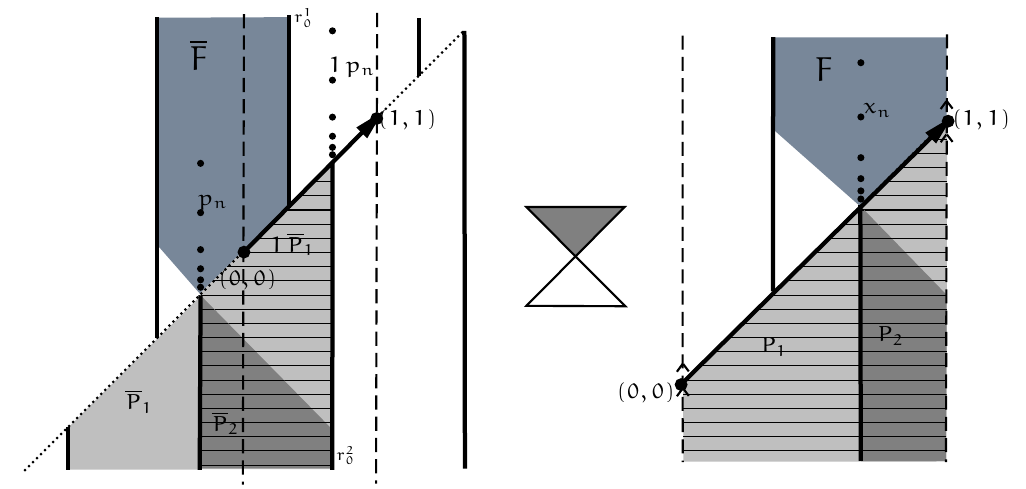
g f r 2 g n and n removed, where n n = f ( 2=3 + n; t ) : t 6 2=3 + n g . The action of an element g of n